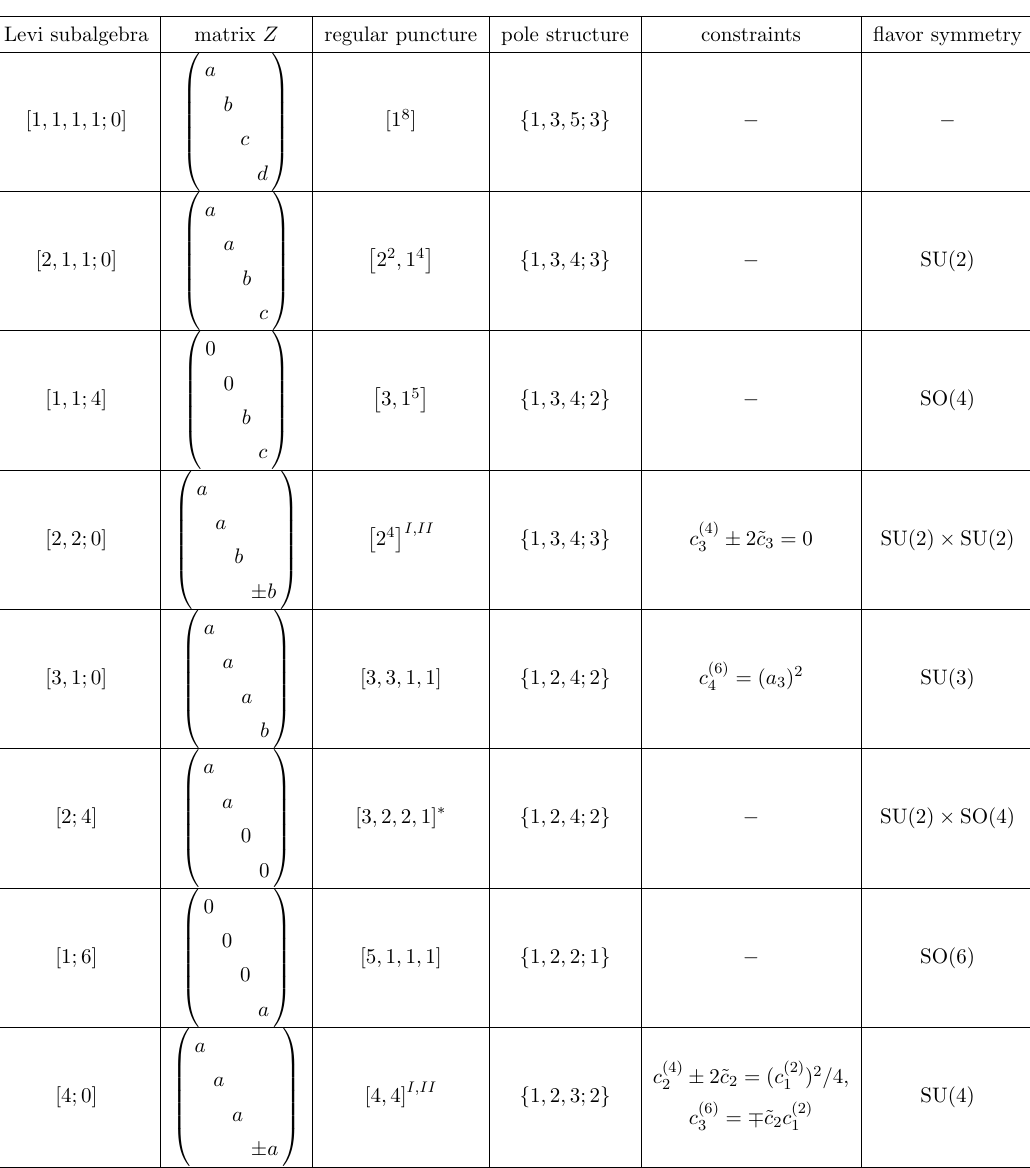
Table 8 . Association of a nilpotent orbit to a Levi subalgebra for D 4 . Here Z follows the convention we list the semisimple part of maximal possible (cid:13)avor symmetry. The partition [5 ; 3] and [7 ; 1]